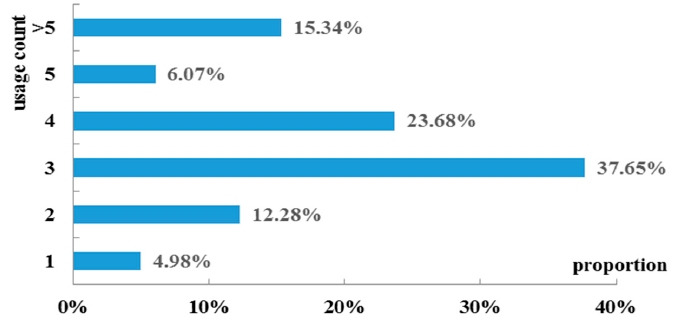
Figure 7. Use frequency.